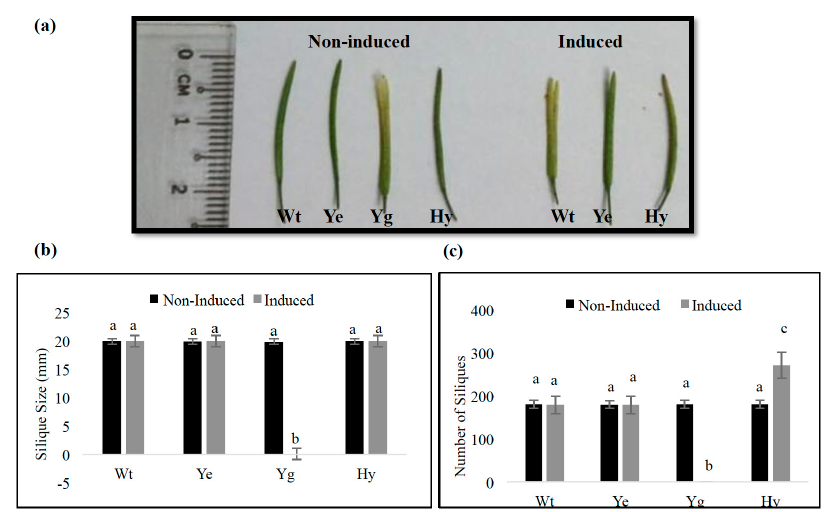
Figure 7. Silique phenotypes in induced and non-induced plants at nine weeks after germination. ( a ) Silique size of non-induced and induced plants; ( b ) Comparison of mean silique size harvested from each non-induced and induced plant; and ( c ) Mean number of siliques harvested from non-induced and induced plants. Wt: wild-type A. thaliana ; Ye: A. thaliana ( yefM Spn ); Yg: A. thaliana ( yoeB Spn -GFP ); Hy: A. thaliana ( yefM Spn × yoeB Spn -GFP ) hybrid. Data in ( b , c ) are presented as the mean ± standard deviation ( n = 20); significance values (with significant differences between samples indicated by the letters a, b and c) were determined by one-way ANOVA (Tukey used as the post hoc test with p < 0.05).